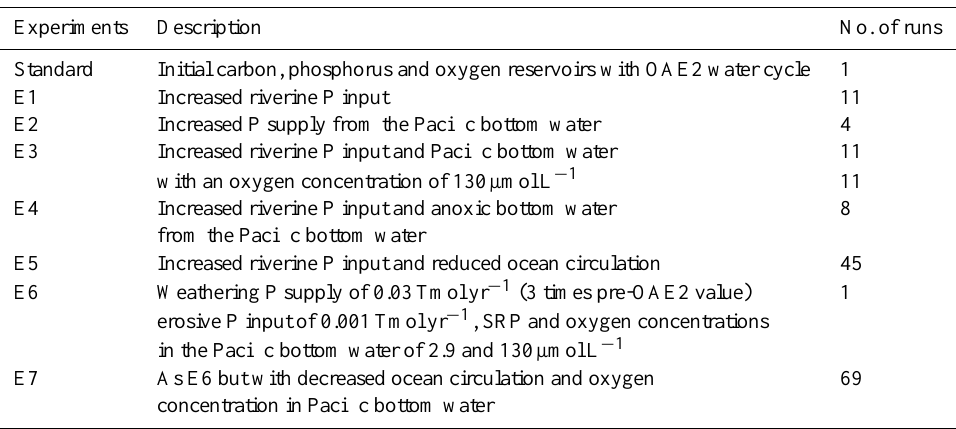
Table 3. Summary of experiments starting from the standard run in OAE2 conditions, with the description and the total number of runs for each